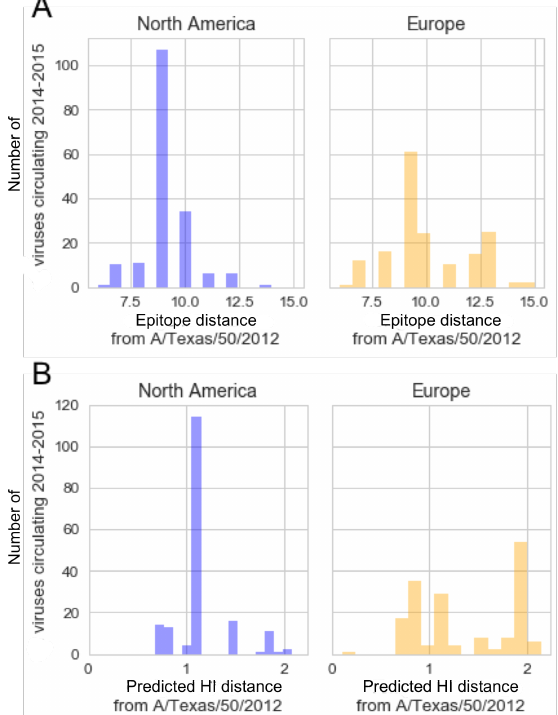
Figure A17. Distributions of circulating H3N2 strains with given antigenic distances from the 2014–2015 vaccine strain (A/Texas/50/2012), stratified by region. Antigenic distances in ( A ) are calculated as Hamming distances between epitope sites, as defined in [60]. H3N2 strains in North America were more antigenically distant from the vaccine strain by epitope Hamming distance (9.2 units, 95% CI: 9.0–9.4) compared to Europe (10.0 units, 95% CI: 9.7–10.3). Antigenic distances in ( B ) are calculated using HI titers [56,59]. North American H3N2 strains are significantly less distant from the vaccine strain (1.17 units, 95% CI: 1.12–1.21) compared to Europe (1.34 units, 95% CI: